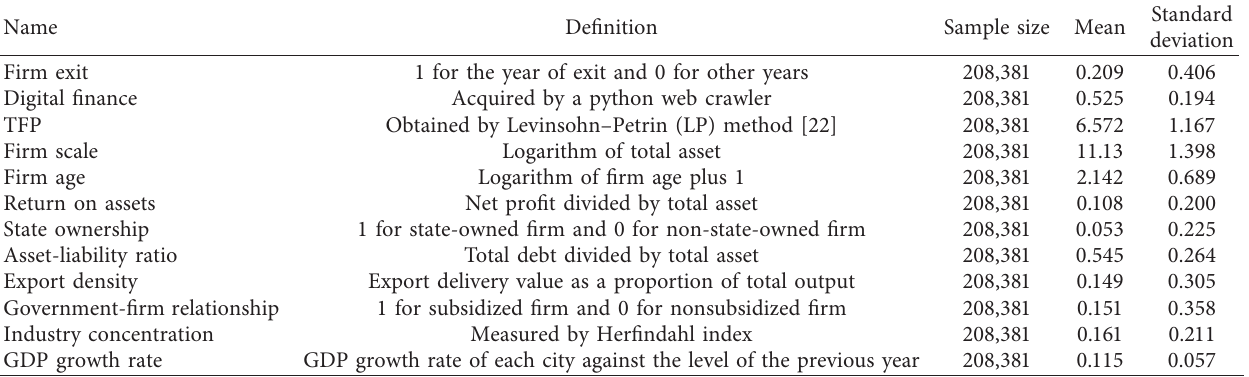
Table 2: Variable definitions and descriptive statistics.